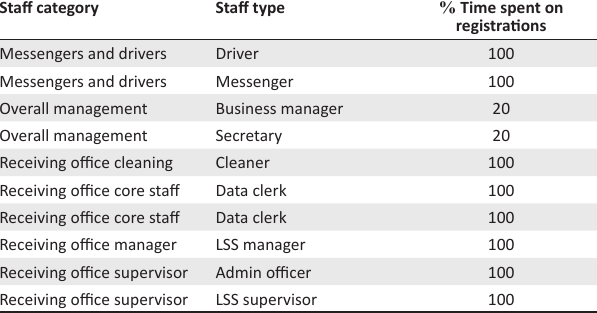
TABLE 1: Percentage of time spent on registrations by staff categories and types at the Charlotte Maxeke Johannesburg Academic Hospital laboratory receiving office, South Africa, April 2019 – March